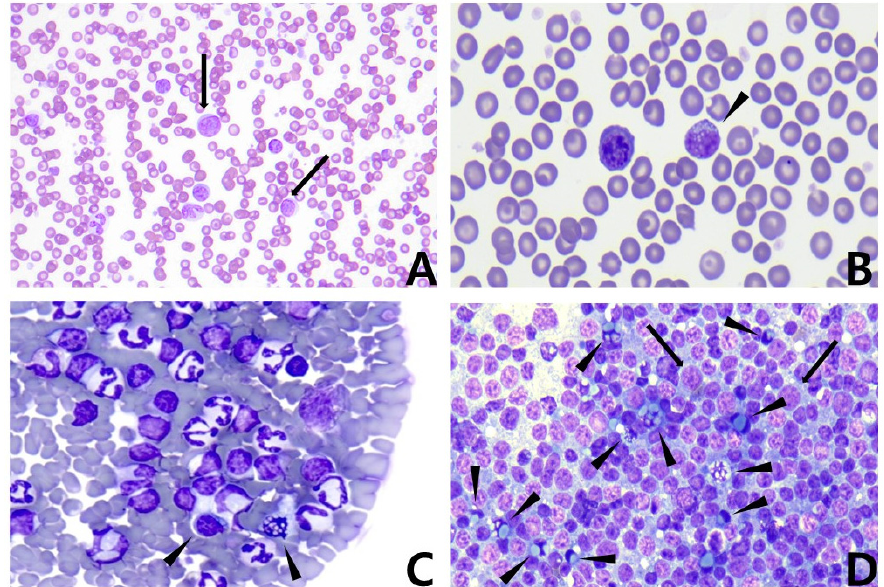
Figure 1. Microscopic images. Modified Wright’s stain. × 40 objective; ( A ) Peripheral blood smear. Arrows indicate lymphoblasts. ( B ) Peripheral blood smear. Arrowhead indicates Mott cell. ( C ) Pe- ripheral blood smear. Arrowheads indicate Mott cells. ( D ) Fine-needle aspiration cytology (FNAC) of the right prescapular lymph node. Arrowheads indicate Mott cells, whereas arrows indicate lymphoblasts. Note the predominant population of lymphoblasts and its difference in size compared with small lymphocytes.